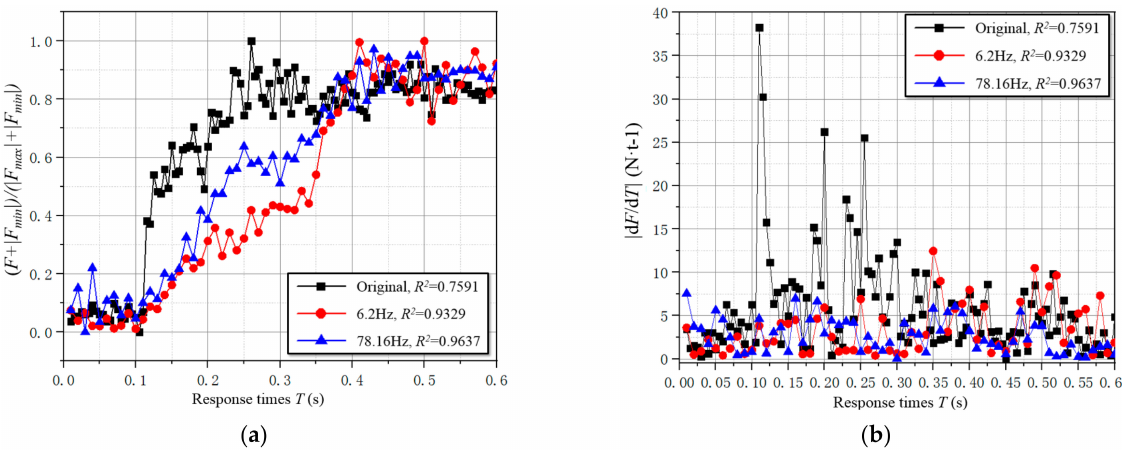
Figure 19. Vector force variation curve under the jet transient vector detachment process condition. ( a ) Comparison of original condition, 6.2 Hz condition, and 78.16 Hz condition; ( b ) vector force differential variation curve.